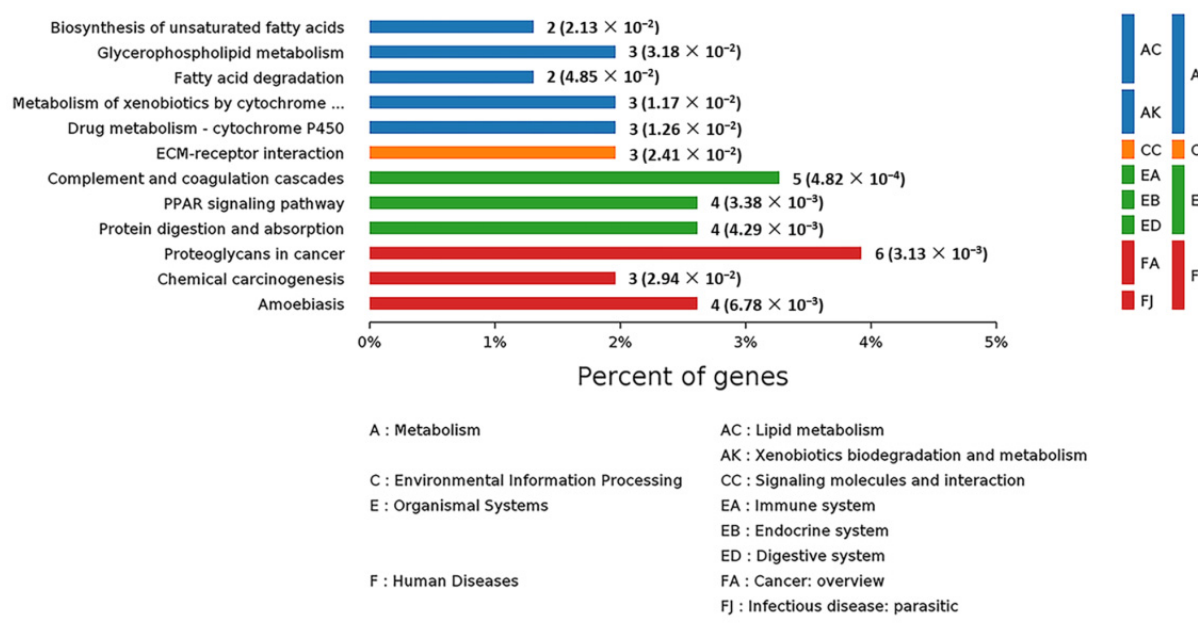
Figure 10. KEGG pathway analysis of the DEPs in livers of Selenot -KO and WT mice. According to the KEGG database, pathways are clustered into four sub-categories, ( A ) Metabolism, ( C ) Environ- mental Information Processing, ( E ) Organismal Systems and ( F ) Human Diseases.